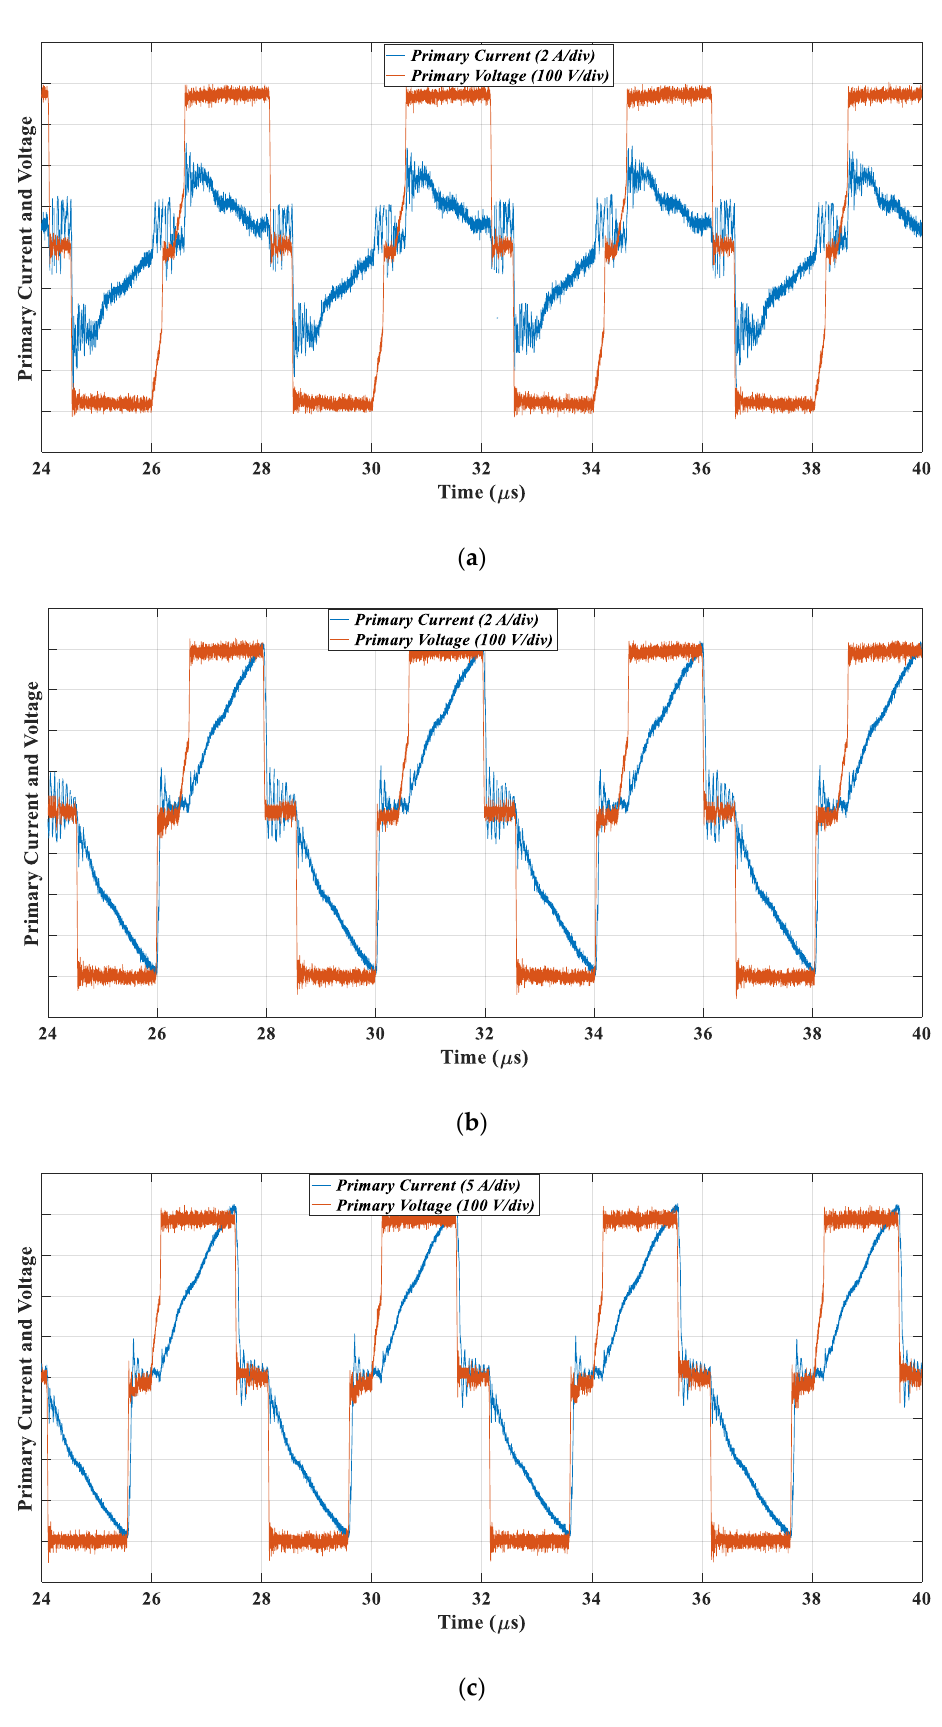
Figure 10. Measured operation waveforms at 250 kHz and output powers of ( a ) 800 W, ( b ) 3 kW,